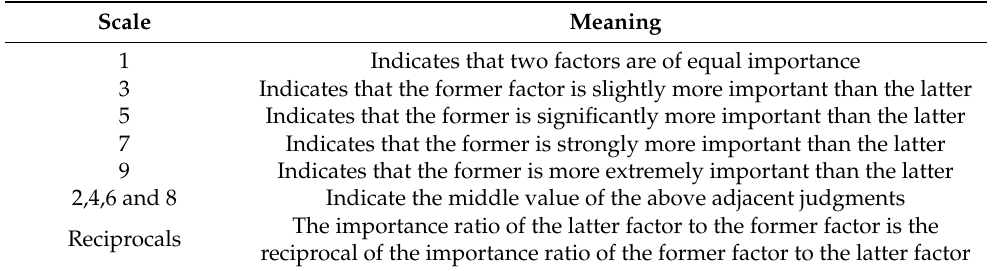
Table 11. Definition of judgment matrix scales.